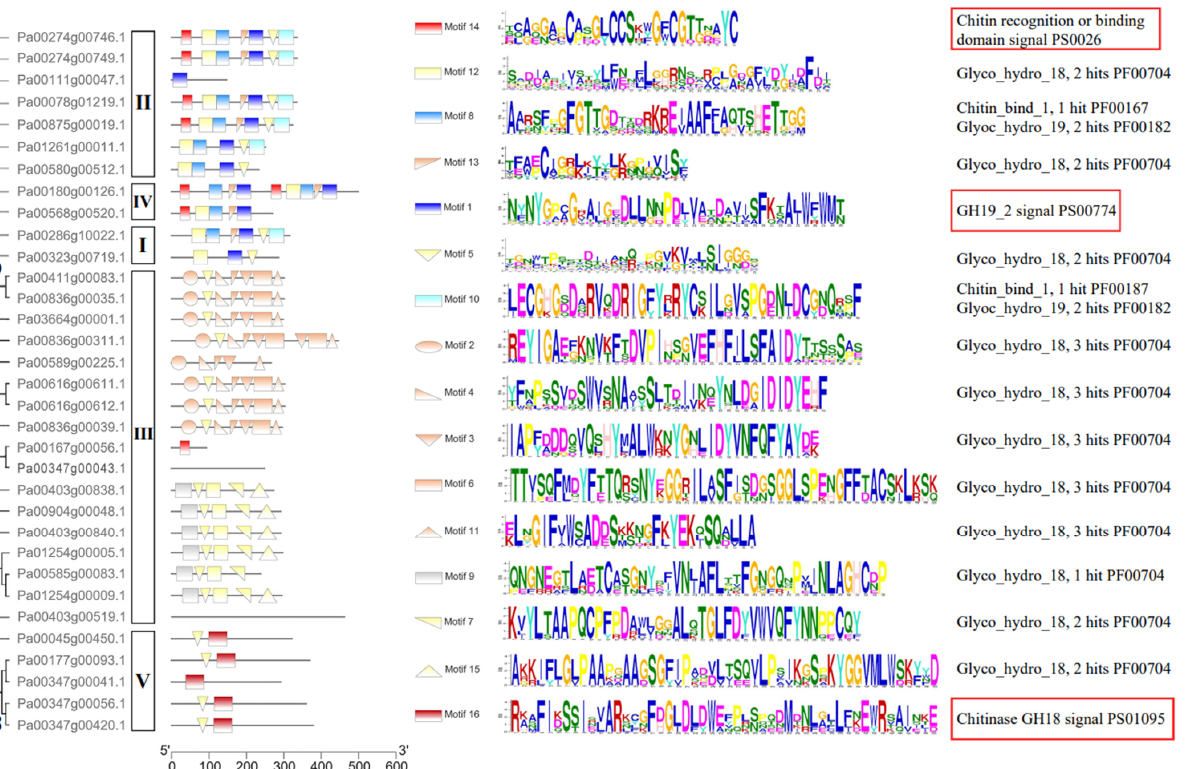
Figure 2. Domain architecture of predicted PaCTLs . The motifs indicated by red boxes were the typical motifs of the GH18 and GH19 subgroups.